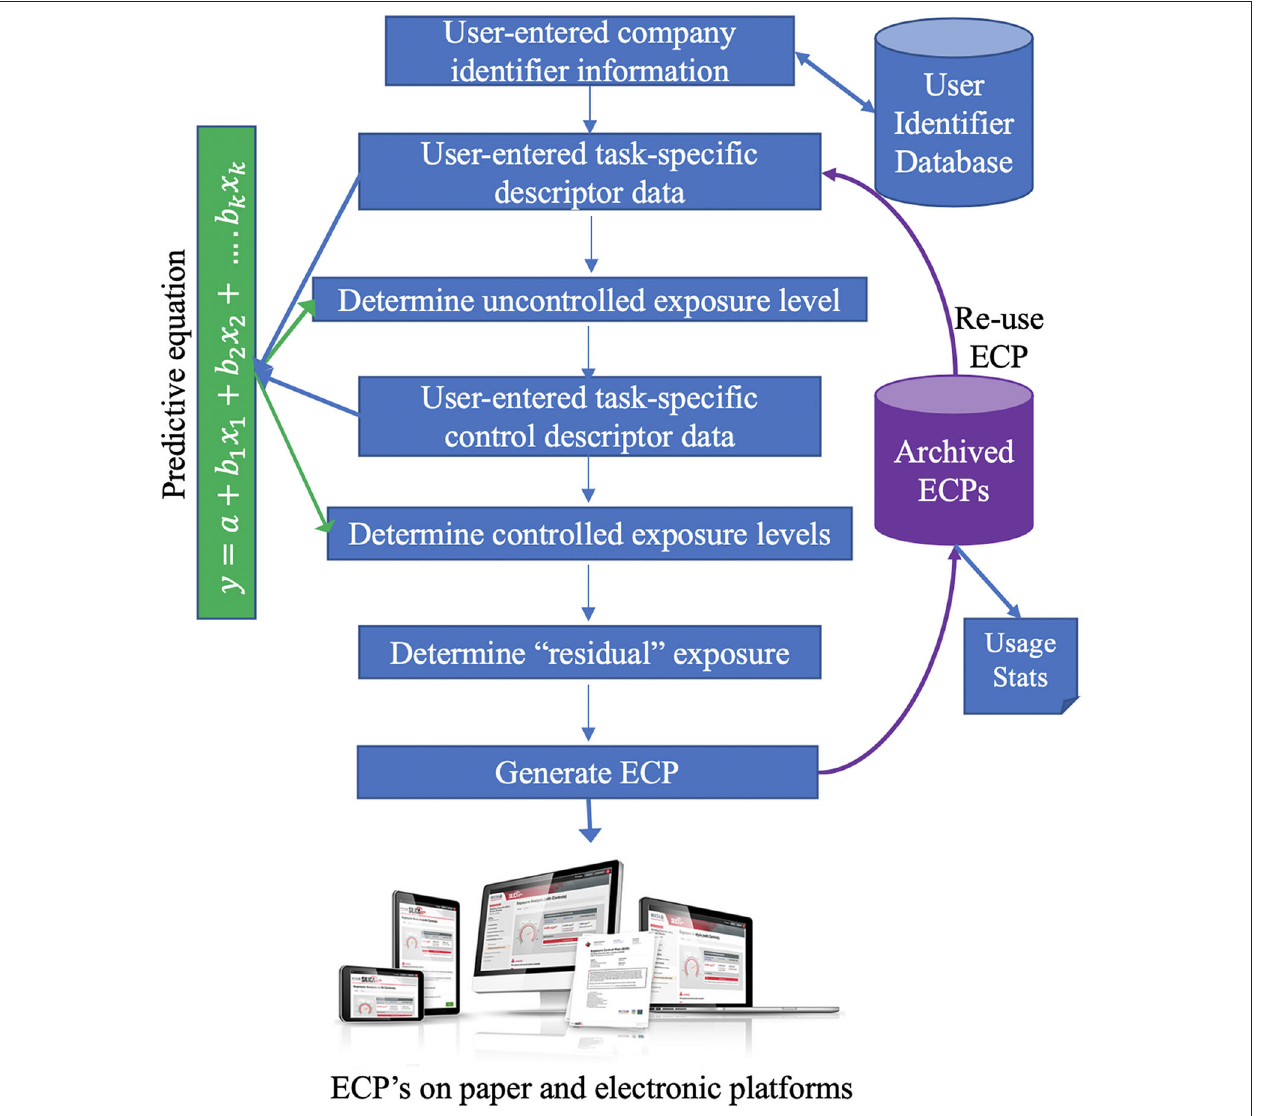
FIGURE 3 | Data flow and gross logic of on-line risk assessment tool. Company identifier data is used for accountability and in report generation. Archived ECP’s can be re-used as the basis for new ECP’s to reduce repetition. Users enter descriptive information about the task to be performed and the predictive model estimates exposure concentrations for the uncontrolled and controlled exposure scenario. Users can iterate this step to do “what-if” estimates. Final product is an “exposure control plan” that meets regulator’s requirements; in electronic form it can be easily distributed to work